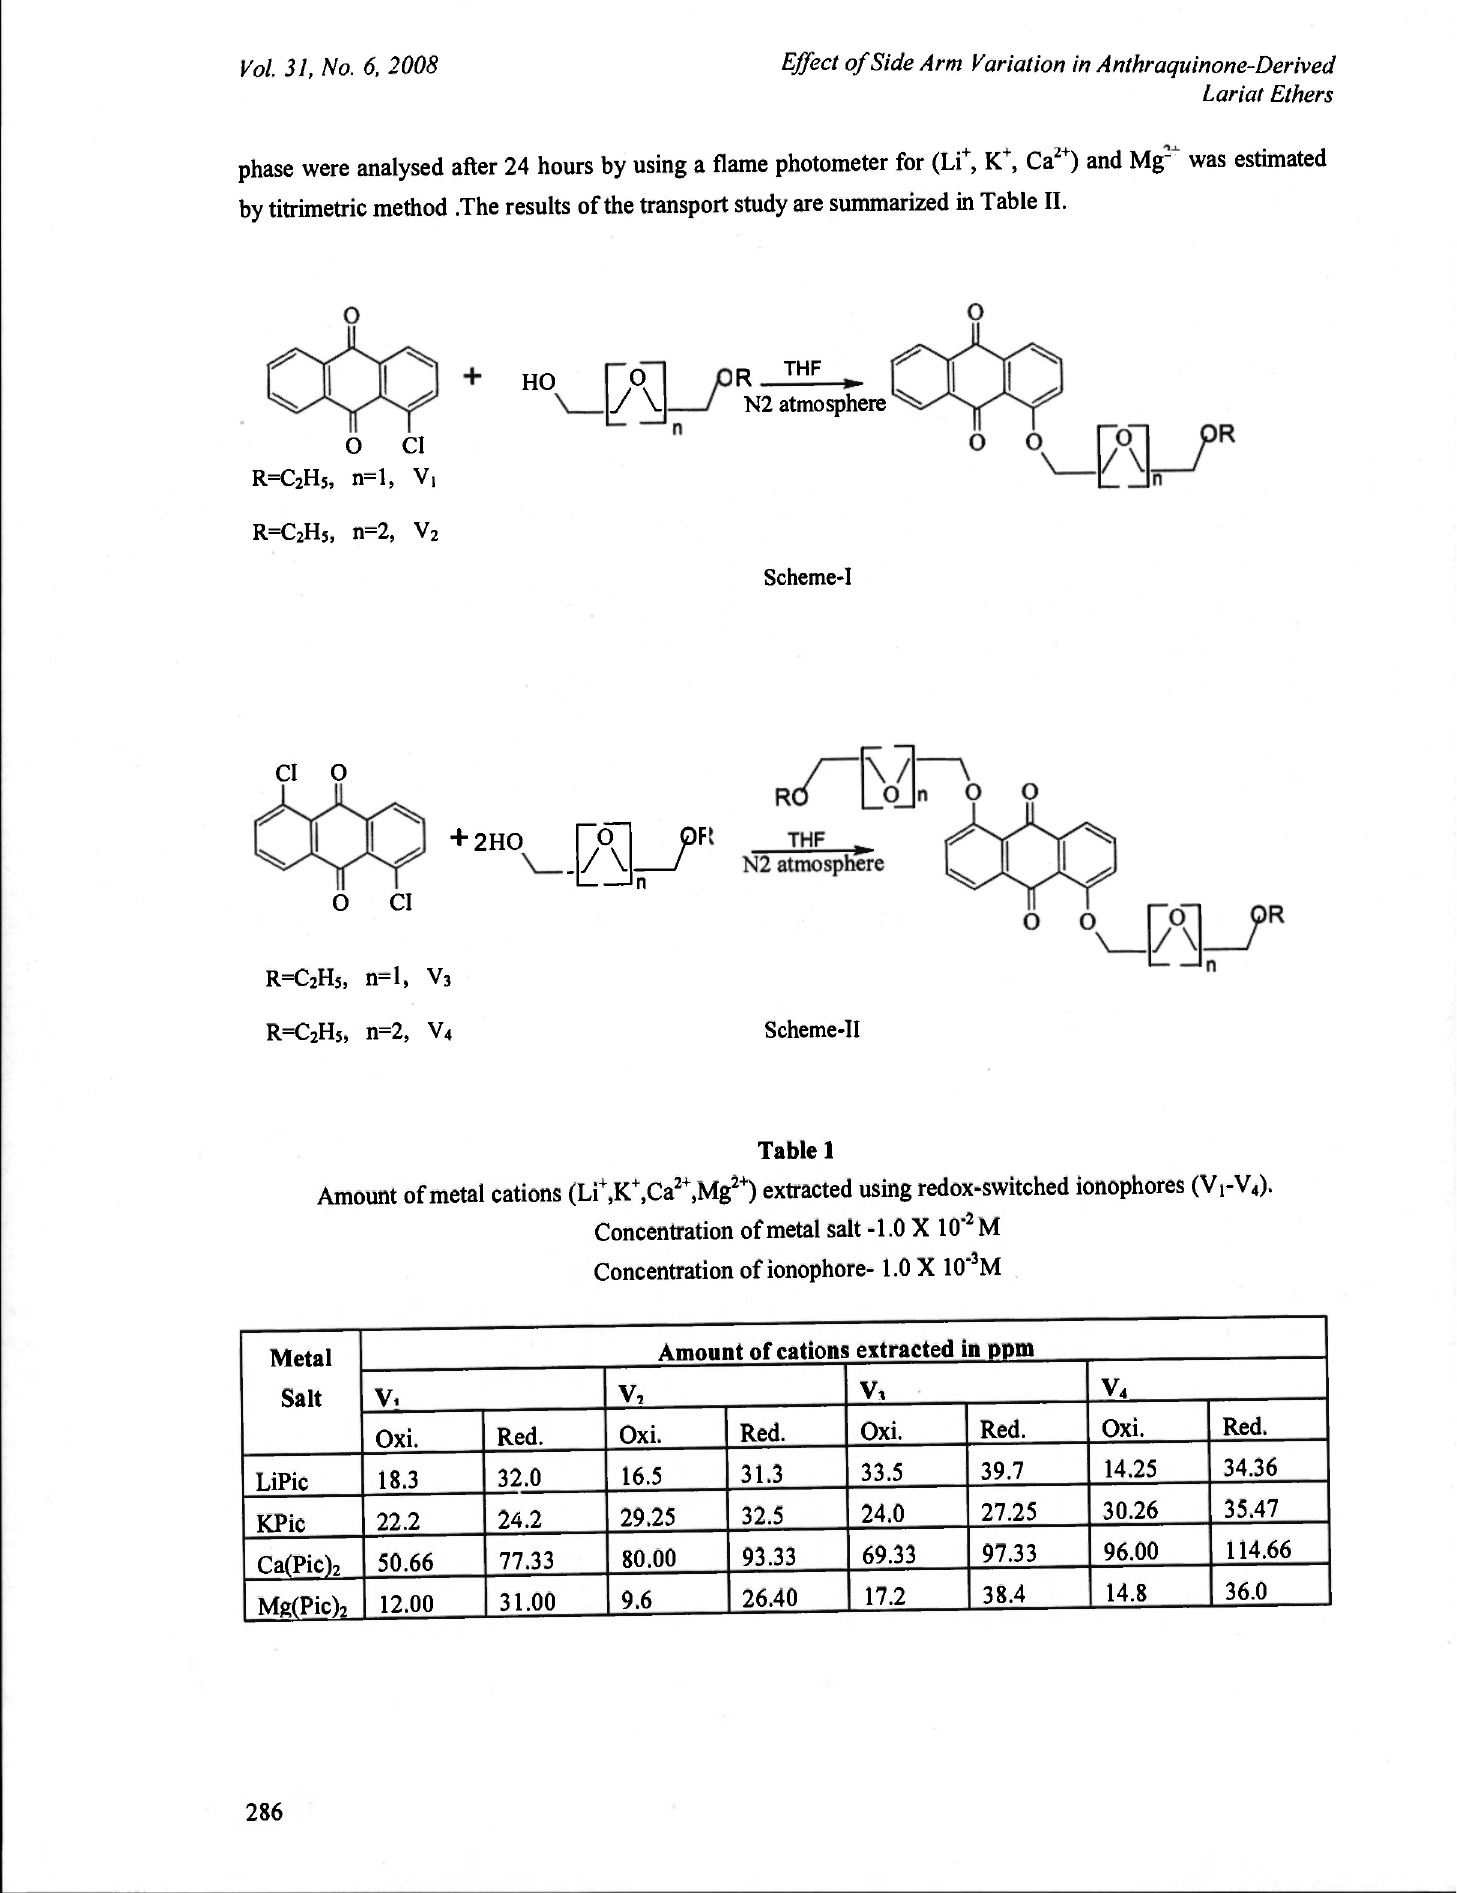
Amount of metal cations (Li + ,K + ,Ca 2+ ,Mg 2+ ) extracted using redox-switched ionophores (V,-V 4